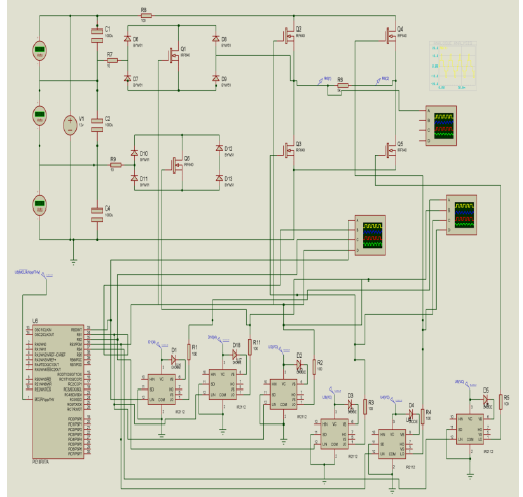
Figure 18 . Schematic of Modified Seven-Level Inverter using PROTEUS Software